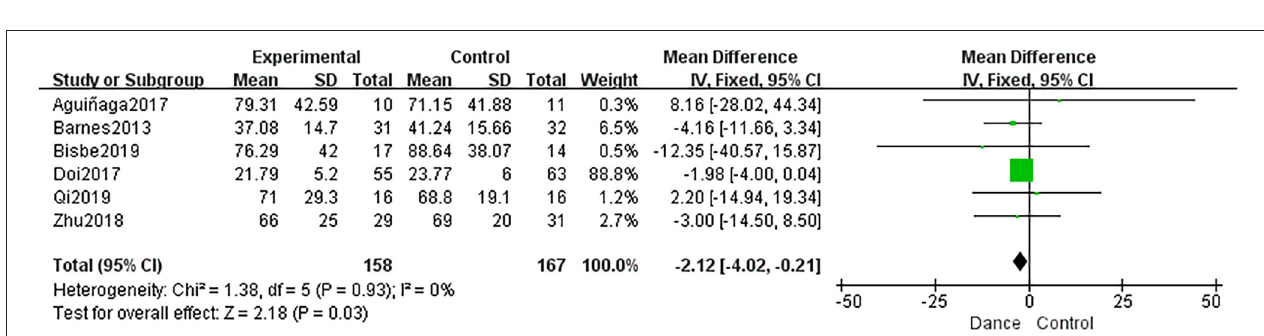
FIGURE 4 | Forest plot of global cognition results of dance group vs. control group (sensitive analysis).